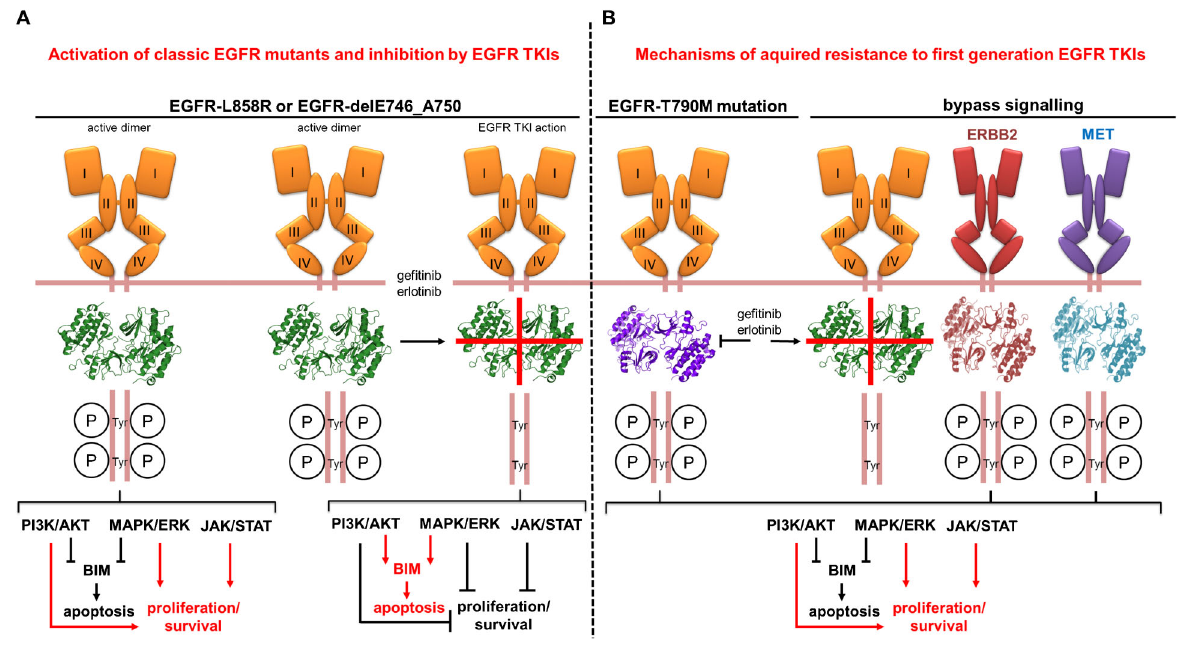
Figure 3. A , Mechanism of activation of the JAK/STAT, MAPK/ERK and PI3K/AKT pathways by epidermal growth factor receptor (EGFR) mutations and their inhibition by EGFR tyrosine kinase inhibitors (TKIs). B , Mechanisms of acquired resistance to EGFR TKIs in EGFR mutated non-small-cell lung cancer (NSCLC) with emphasis on the EGFR-T790M resistant mutation and oncogene bypass tracks that re-activate downstream signaling